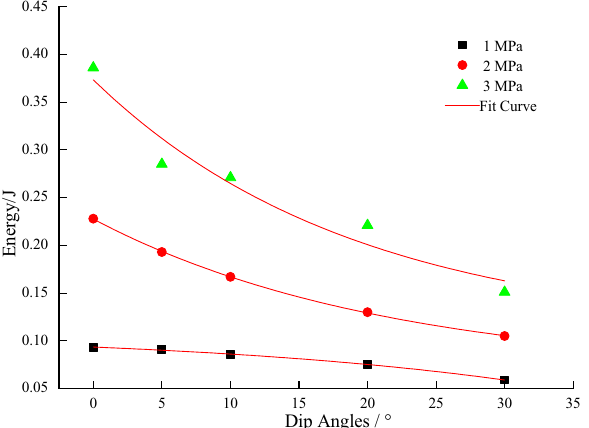
Figure 7. The relationship between peak front dissipation energy and angle.